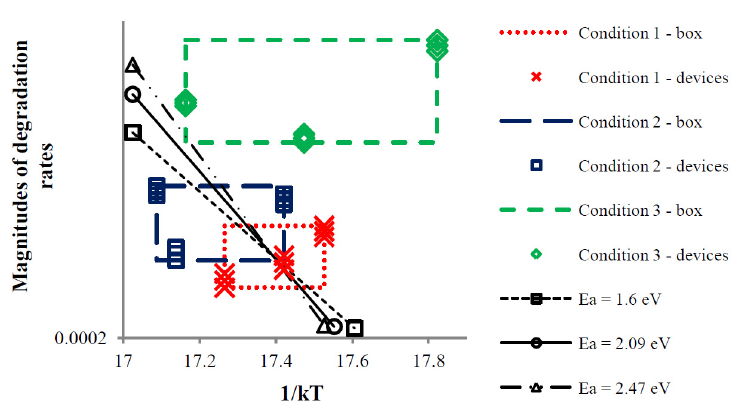
Figure 4. Magnified portion of Figure 3.